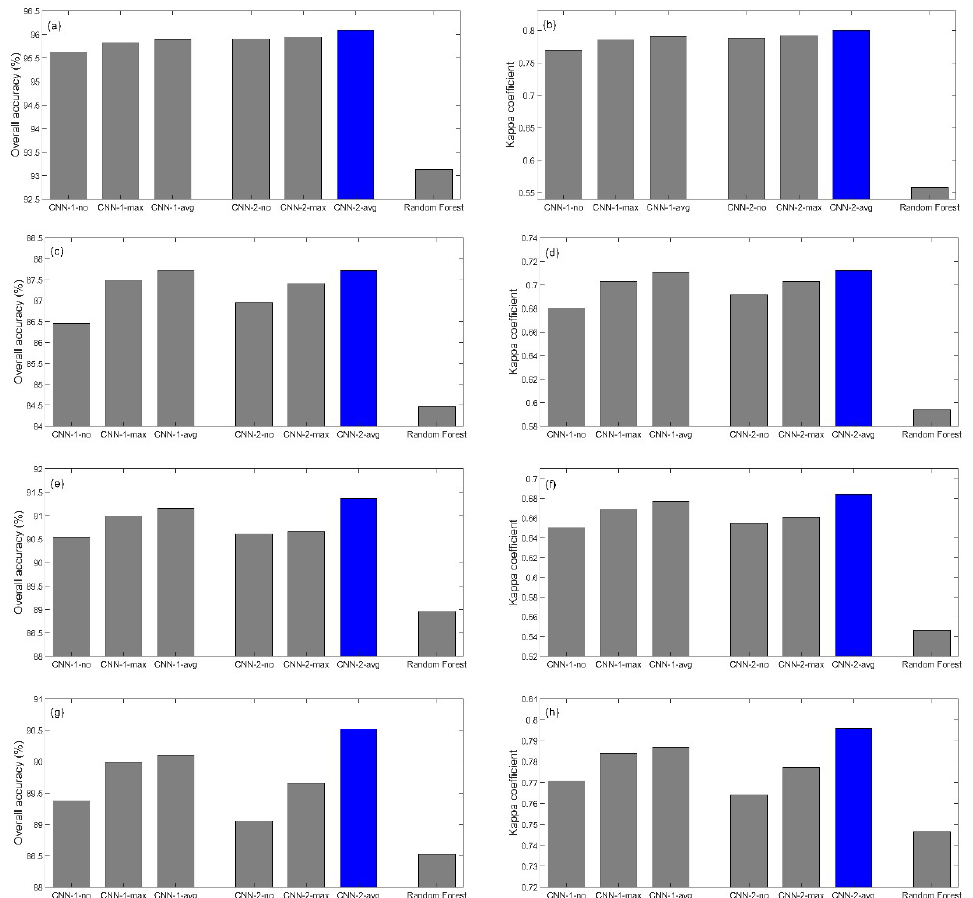
Figure 6. (a) and (b) show the six CNN model and random forest overall accuracies (a) and kappa coe ffi cients ( b ) of the study area 1 testing sample classification. ( c ) and ( d ) show the same for study area 2 testing sample classification, ( e ) and ( f ) for study area 3 testing sample classification, and ( g ) and ( h ) for study area 4 testing sample classification. CNN1 and CNN2 indicate the first and second CNN structure settings with ~70,000 and ~290,000 learnable parameters, respectively. -no, -max and -avg indicate no, max and average pooling, respectively. The blue color is used to indicate the best performance CNN model among the six models.